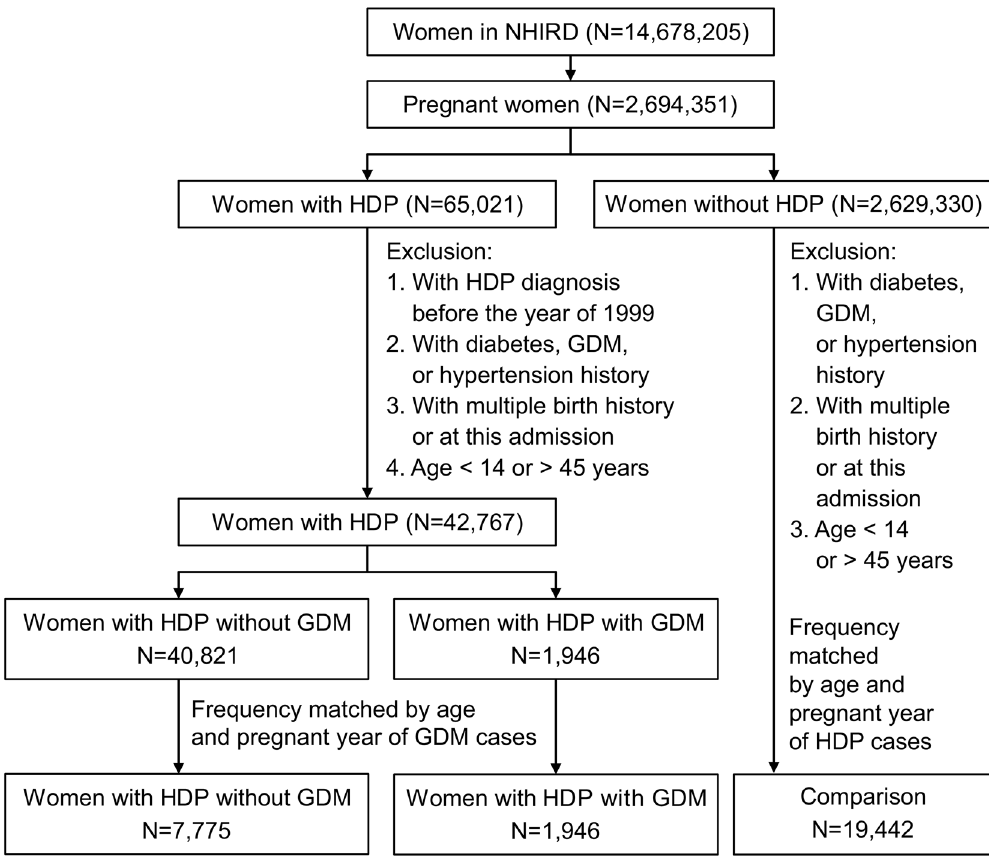
Figure 2. Flow chart for establishing study